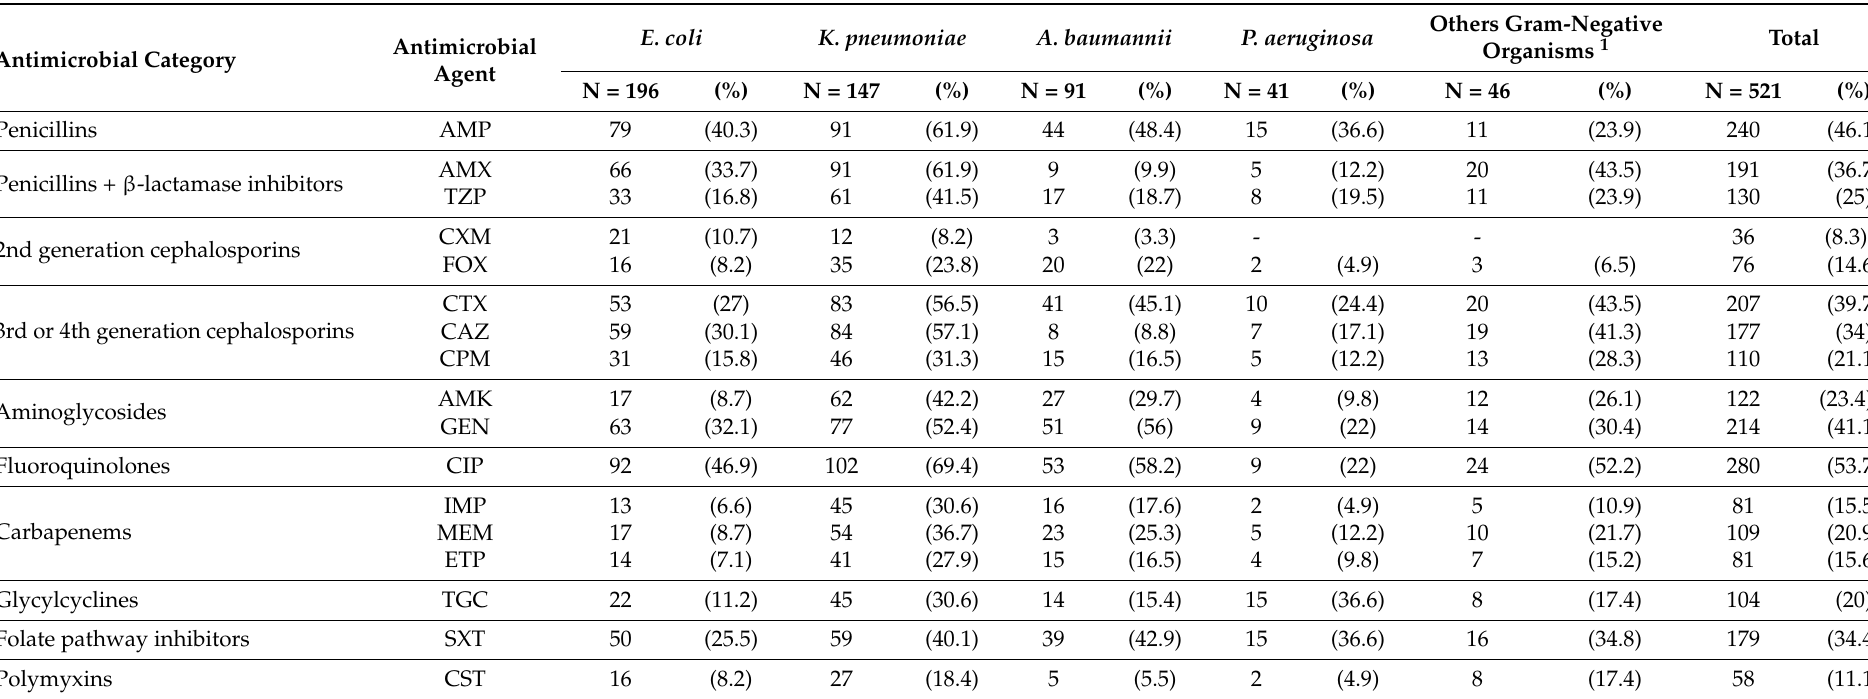
Table 3. Distribution of the antimicrobial resistant phenotype among Gram-negative organisms by bacterial species and tested antimicrobial agents.